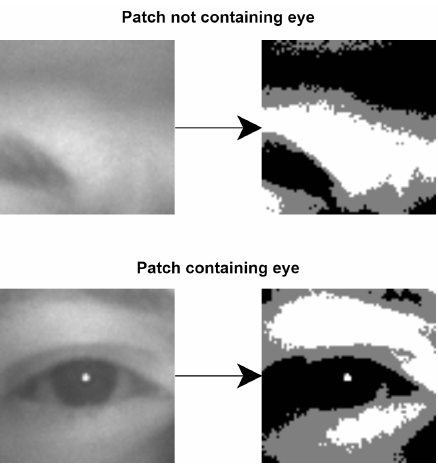
Figure 4. Top is a patch from the search area which does not contain an eye converted from grayscale to black–gray–white. Bottom is a patch from the search area which definitely contains an eye converted from grayscale to black–gray–white.